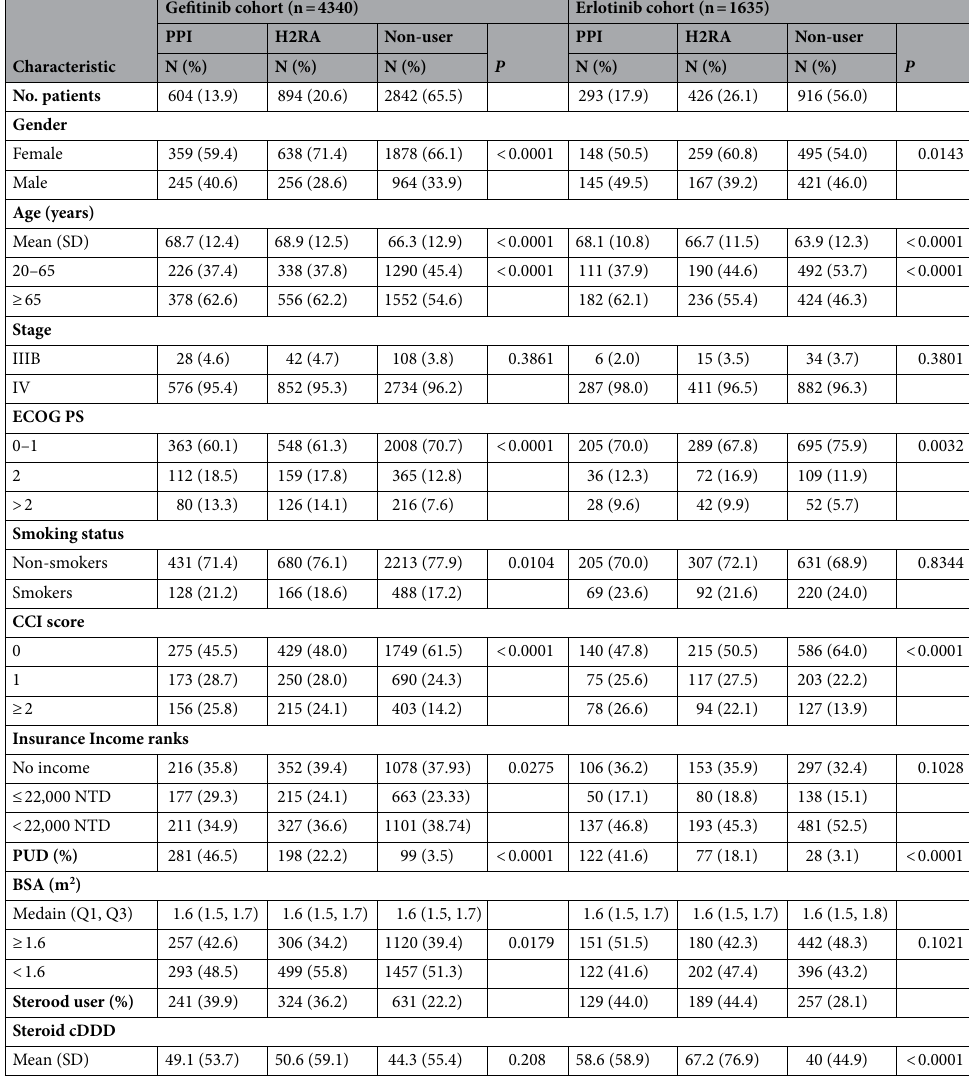
Table 1. Patients characteristics of gefitinib and erlotinib cohort. There were missing data in ECOG PS (gefitinib: n = 363; erlotinib: n = 107), Smoking status (gefitinib: n = 234; erlotinib: n = 111) and BSA (gefitinib: n = 408; erlotinib: n = 142). PPI proton pump inhibitor, H2RA histamine-2 receptor antagonist, ECOG PS Eastern Cooperative Oncology Group performance status, CCI charlson comorbidity index, NTD new Taiwan dollar, BSA body surface area, PUD peptic ulcer disease, cDDD cumulative defined daily